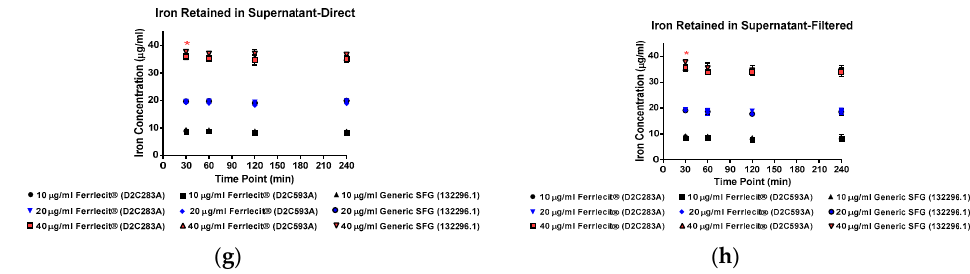
Figure 3. Comparison of iron uptake in U937 cells. Data are presented as mean ± SD ( n = 3, three independent experiments with four replicates for each experimental condition). A p -value < 0.05 was considered statistically significant, marked with *. ( a ) Iron uptake in U937 cells treated with 10 µg/mL drugs was measured from direct centrifugation harvest; ( b ) iron uptake in U937 cells treated with 20 µg/mL drugs was measured from direct centrifugation harvest; ( c ) iron uptake in U937 cells treated with 40 µg/mL drugs was measured from direct centrifugation harvest; ( d ) iron uptake in U937 cells treated with 10 µg/mL drugs was measured from filtered centrifugation harvest; ( e ) iron uptake in U937 cells treated with 20 µg/mL drugs was measured from filtered centrifugation harvest; ( f ) iron uptake in U937 cells treated with 40 µg/mL drugs was measured from filtered centrifugation harvest; ( g ) iron retained in cell culture supernatant was measured from direct centrifugation harvest; ( h ) iron retained in cell culture supernatant was measured from filtered centrifugation harvest.